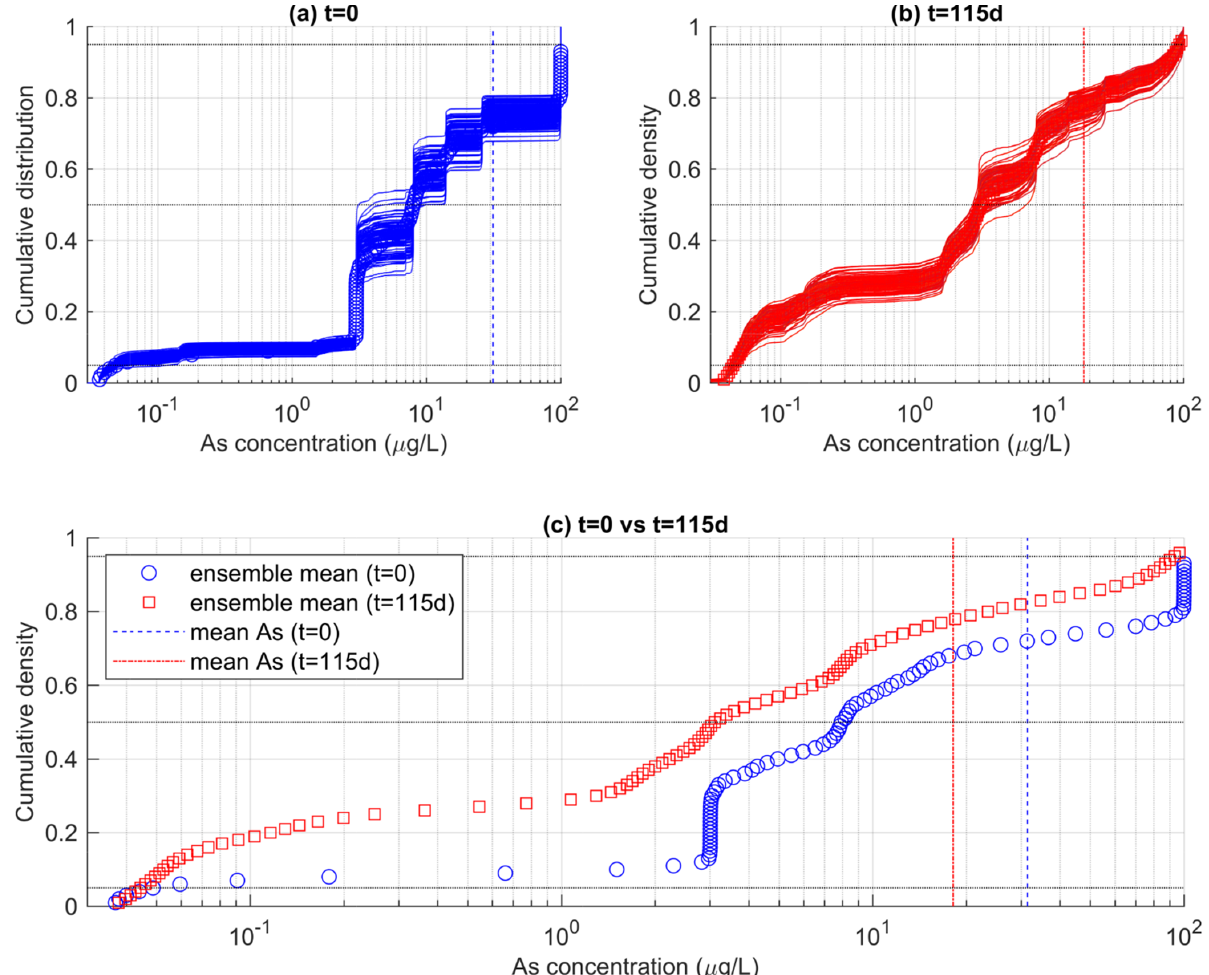
Figure 10. Ensembles of ecdfs of As concentration calculated for the shallow (top six meters) of the aquifer ( a ) at the beginning of the simulations (t = 0) and ( b ) at the end of the simulations (t = 115 d). In ( c ), the ensemble-mean ecdfs are reported, suggesting a time-dependent change in the probability that As does not exceed a specific threshold.